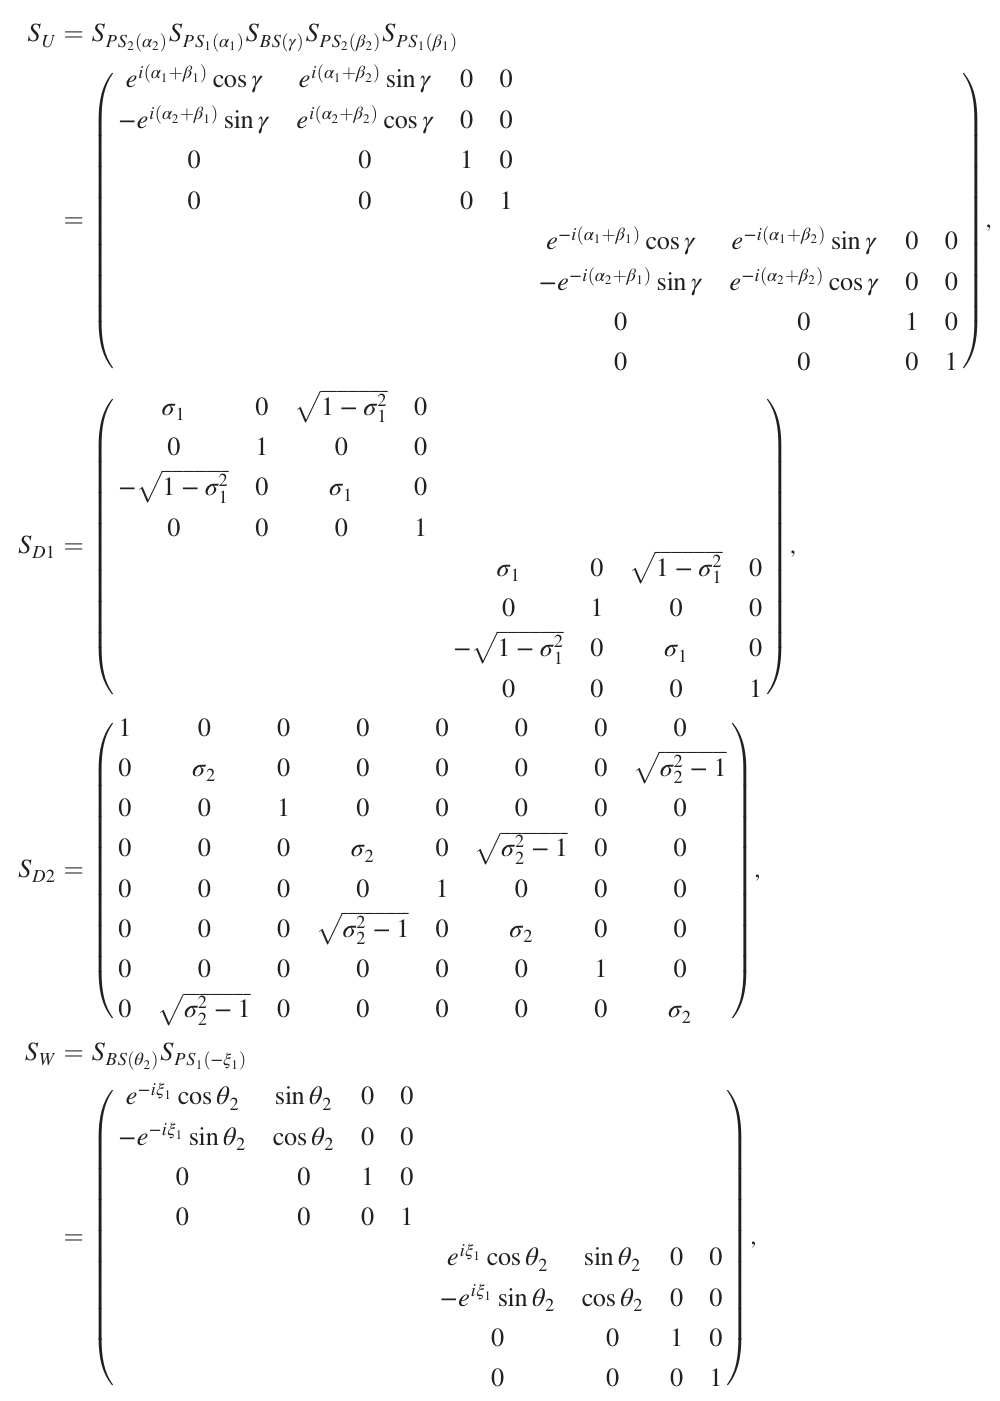
p ffiffiffiffiffiffiffiffiffiffiffiffiffi 1 − σ 2 1 ffiffiffiffiffiffiffiffiffiffiffiffiffi p σ 2 − 1 2